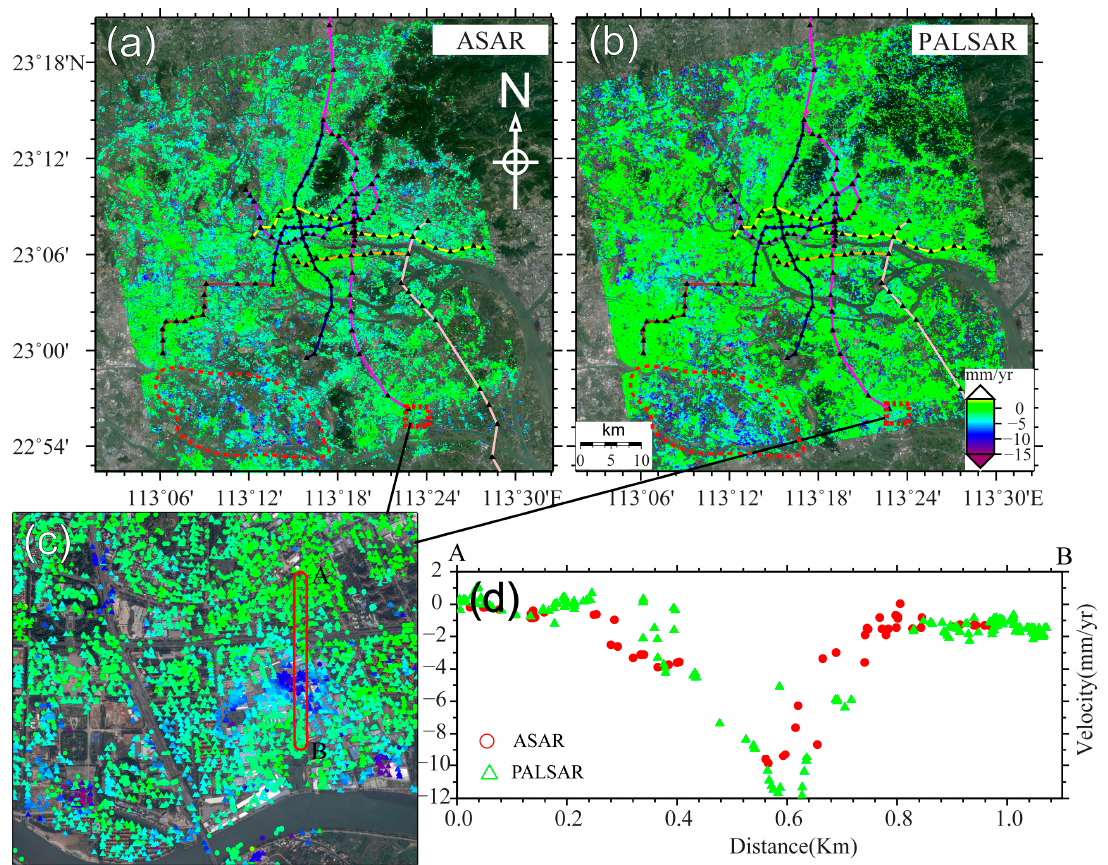
Figure 2. Deformation rates generated by ASAR and PALSAR datasets for the whole study area and their cross validation: ( a ) the deformation velocity ASAR map; ( b ) the deformation velocity PALSAR map; ( c ) the validation area; and ( d ) the profile map of AB in ( c ).